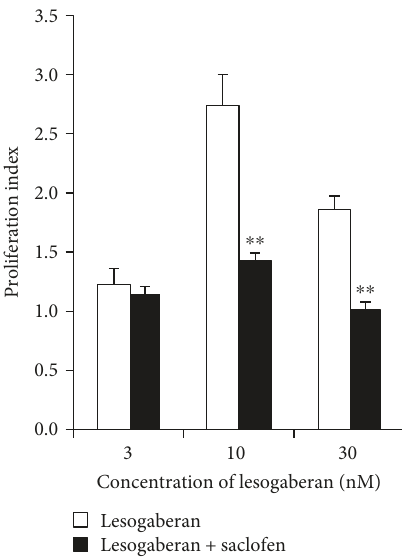
Figure 1: Lesogaberan enhances human islet cell proliferation in vitro . Human islets were treated in triplicate with, or without, the indicated dosages of lesogaberan in the presence (black bars) or absence (open bars) of saclofen (10 − 4 M) for 4 days. Data shown are the average rate of proliferation ± SEM relative to that of cultures with medium alone (designated as 1) using islets from two donors, each of which were studied in separate experiments. Treatment with saclofen alone did not a ff ect the proliferation of human islet in our experimentalsystem(datanotshown). ∗∗ p < 0 01